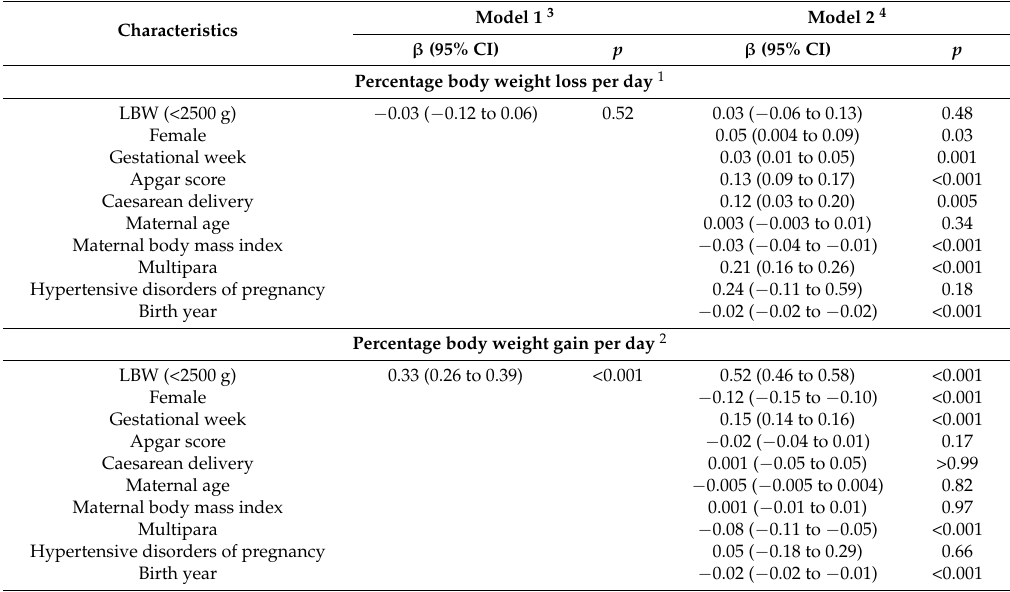
Table 2. Body weight growth patterns against birth weight estimated by multivariable linear regression analysis.